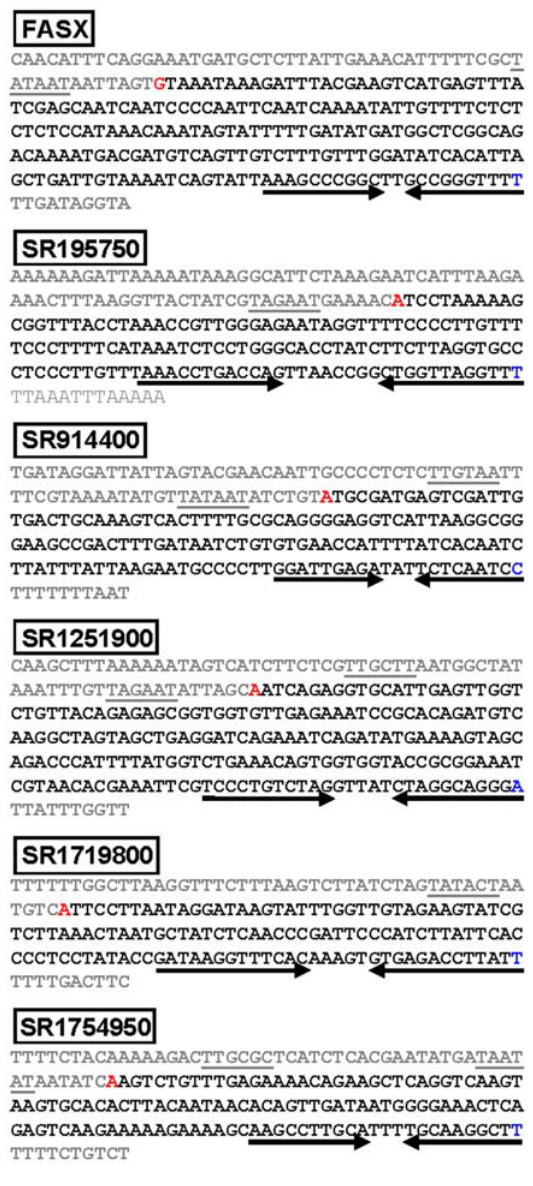
Figure 4. Analysis of candidate sRNA transcriptional start sites, terminators, and promoter regions. The transcriptional start sites of candidate sRNAs FASX, SR195750, SR914400, SR1251900, SR1719800, and SR1754950 were determined by 5 9 RACE. The identified transcrip- tional start site is colored red, the deduced sRNA sequences are colored black, and the final base of the terminator hairpin is colored blue. The putative 2 10 and/or 2 35 promoter sequences are underlined and putative rho-independent (intrinsic) terminators are highlighted by inverted arrows.